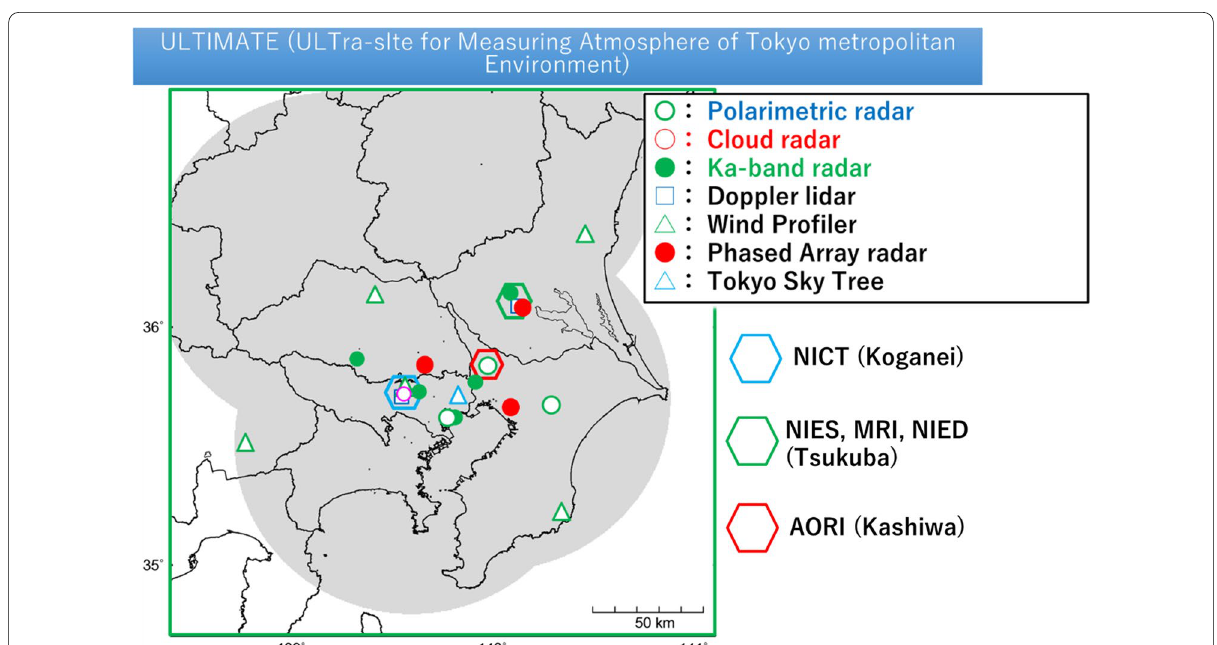
Fig. 1 Map of the ULTIMATE observation network in the Kanto region. Observation instruments are located at the National Institute of Information and Communications Technology (NICT; Koganei City), the National Institute for Environmental Studies (NIES), the Meteorological Research Institute (MRI), the National Research Institute for Earth Science and Disaster Resilience (NIED) (all in Tsukuba City), and the Atmosphere and Ocean Research Institute (AORI; Kashiwa City) of The University of Tokyo. “Polarimetric radar” indicates the Haneda and Narita radars and the Tokyo radar at Kashiwa (the Japan Meteorological Agency)